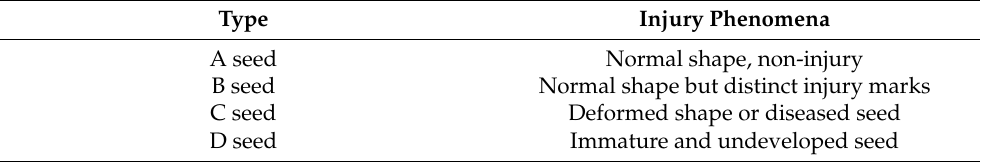
Table 1. Classification of injury types of soybean seeds caused by hemipteran bugs.